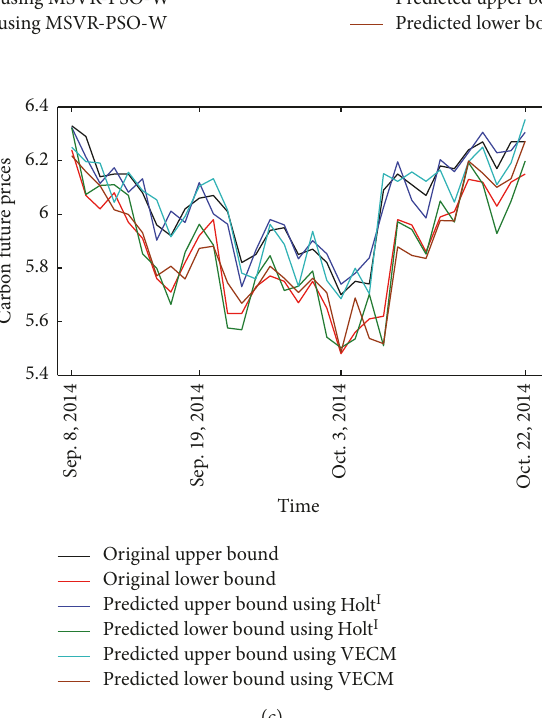
Figure 11: Representative examples of actual intervals versus predicted intervals using (a) MSVR-PSO-W and MSVR-PSO-WO, (b) ANN-W and ANN-WO, and (c) Holt I and